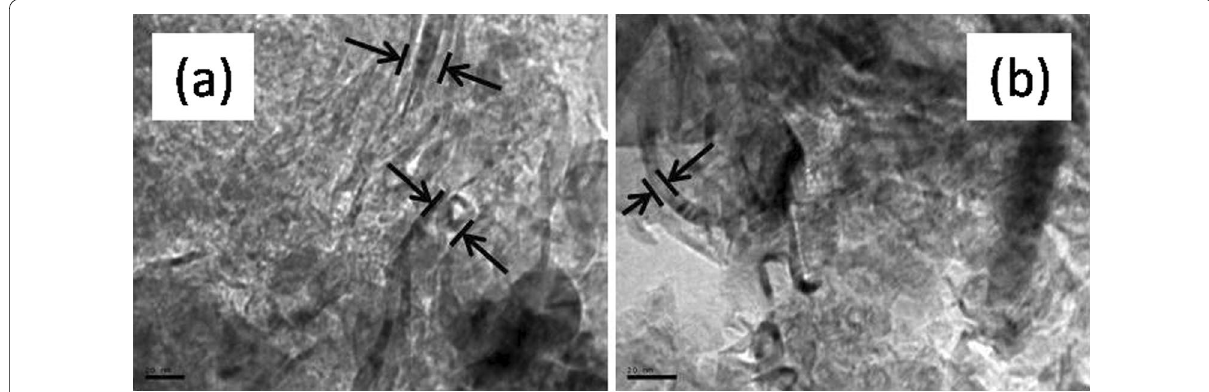
Fig. 1 TEM images of studied CNF samples. Arrows indicate the edges of the fibers